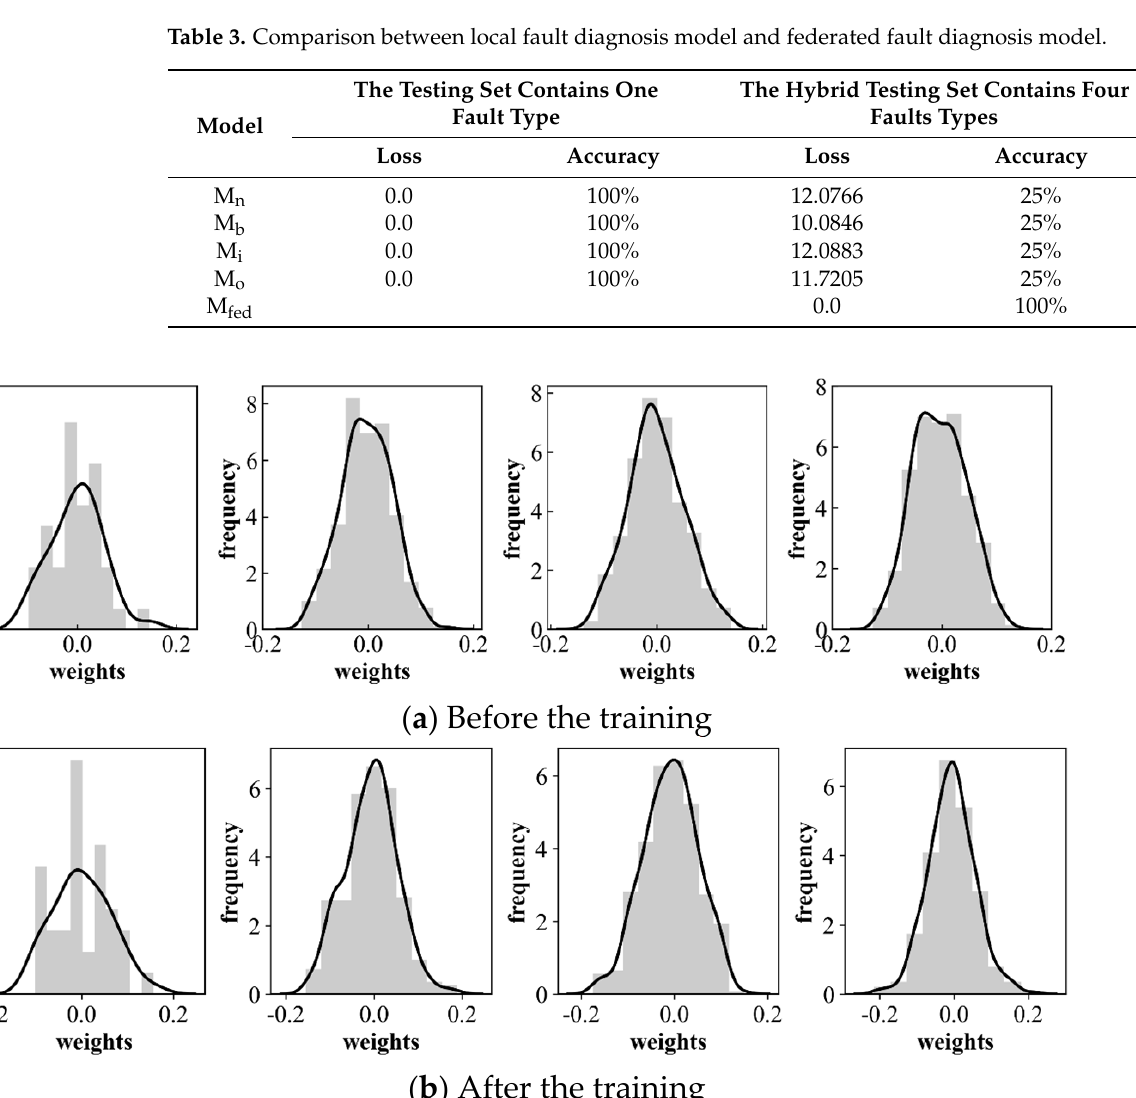
Table 3. Comparison between local fault diagnosis model and federated fault diagnosis model.